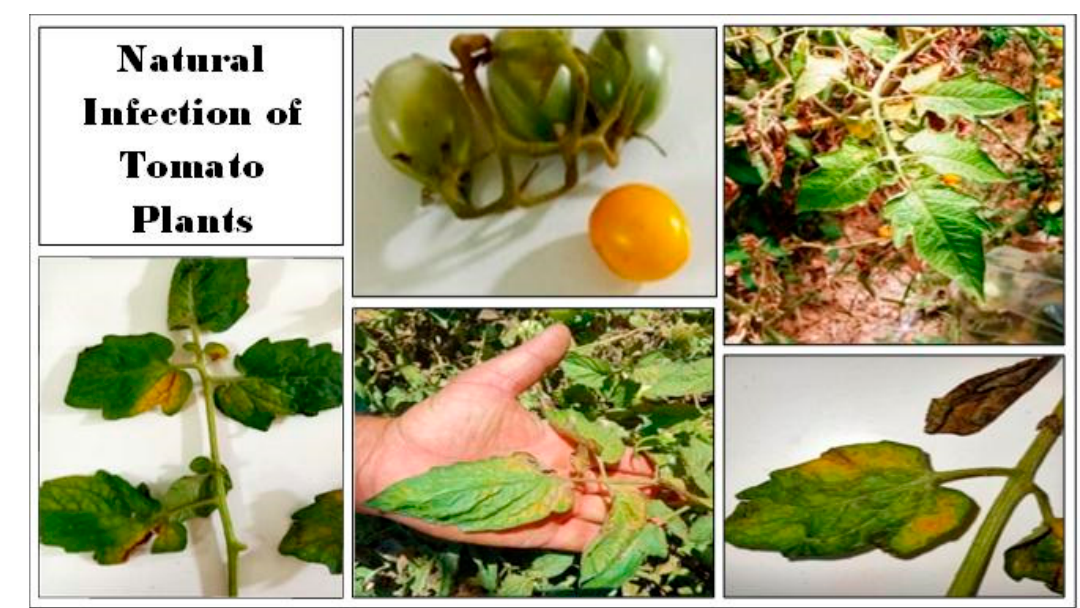
Figure 1. Natural infection of tomato plants with Fusarium wilt disease under open field conditions at a private farm in Borg El-Arab, Alexandria governorate, Egypt.